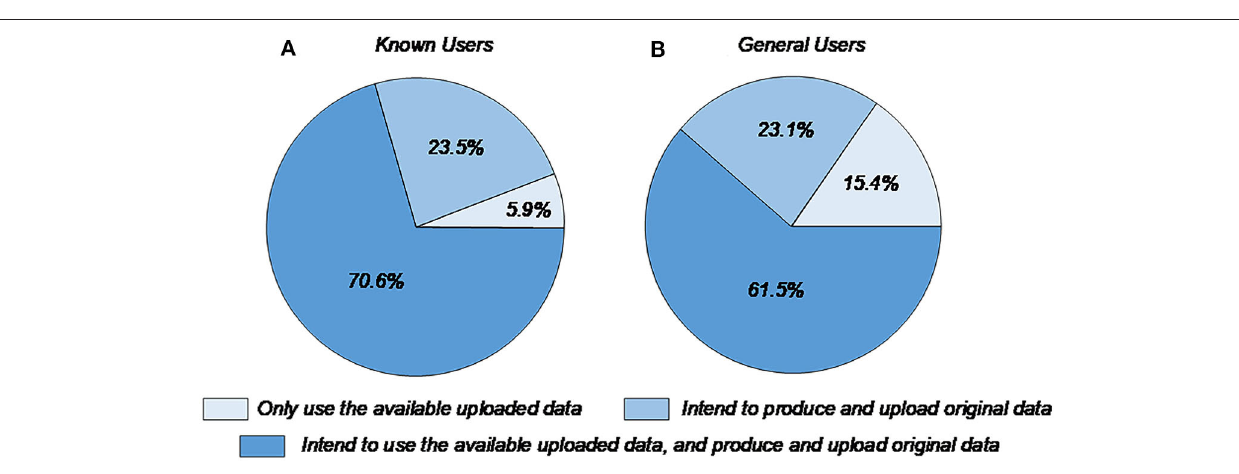
Frontiers in Built Environment |